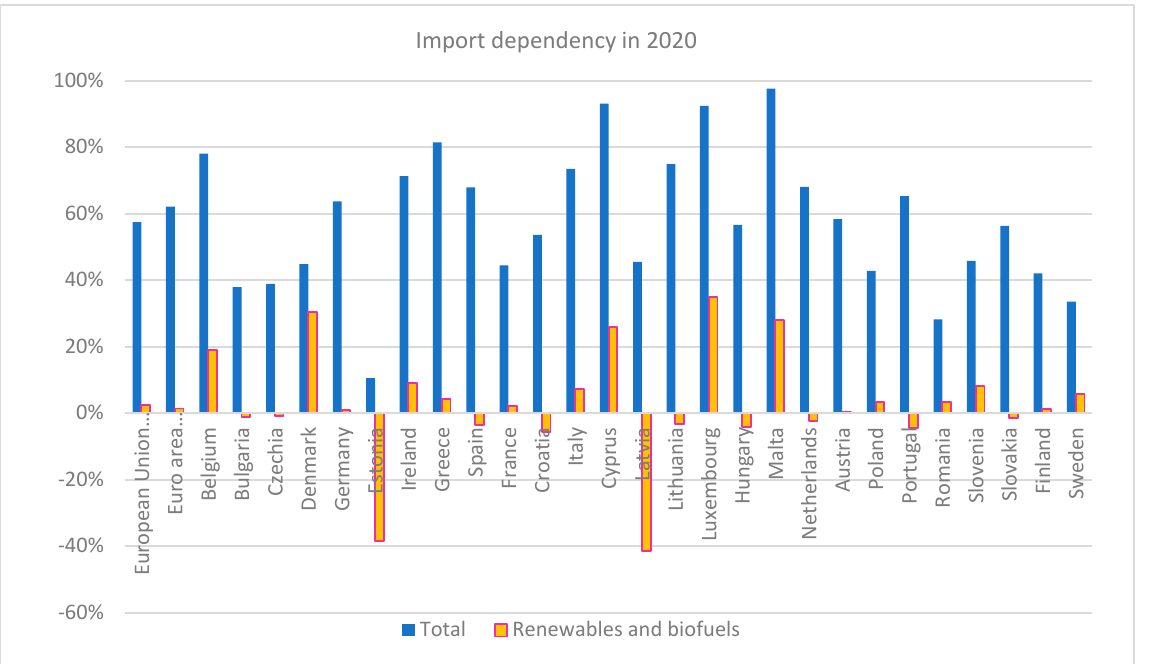
Figure 2. The dependence of the EU member-states on sources of energy. Source: Eurostat, calculation based on energy balances [88].